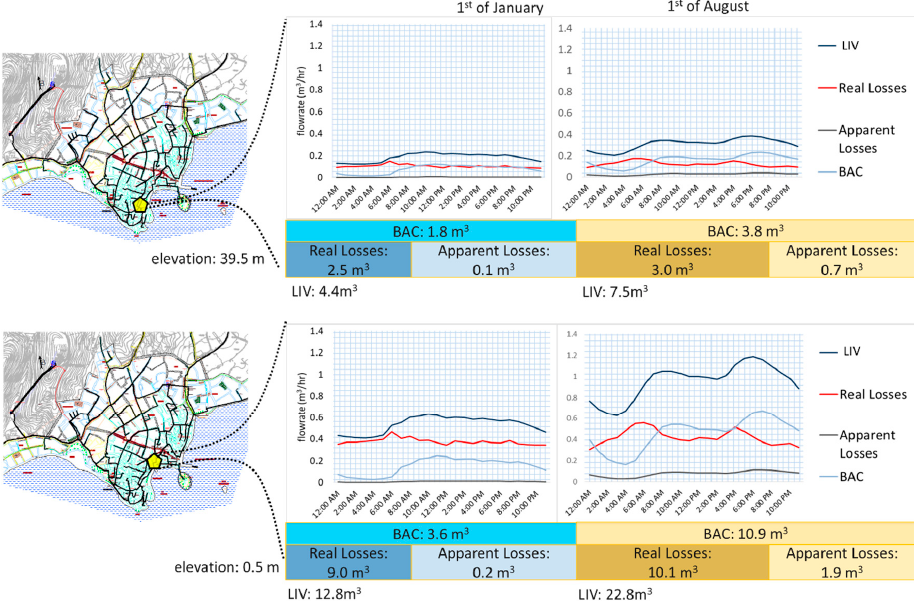
Figure 18. Hourly profiles of landzone input volumes, real and apparent losses, and BAC on 1 January and 1 August, for two indicative neighborhoods of the network with the elevation of 39.5 m and 0.5 m respectively.